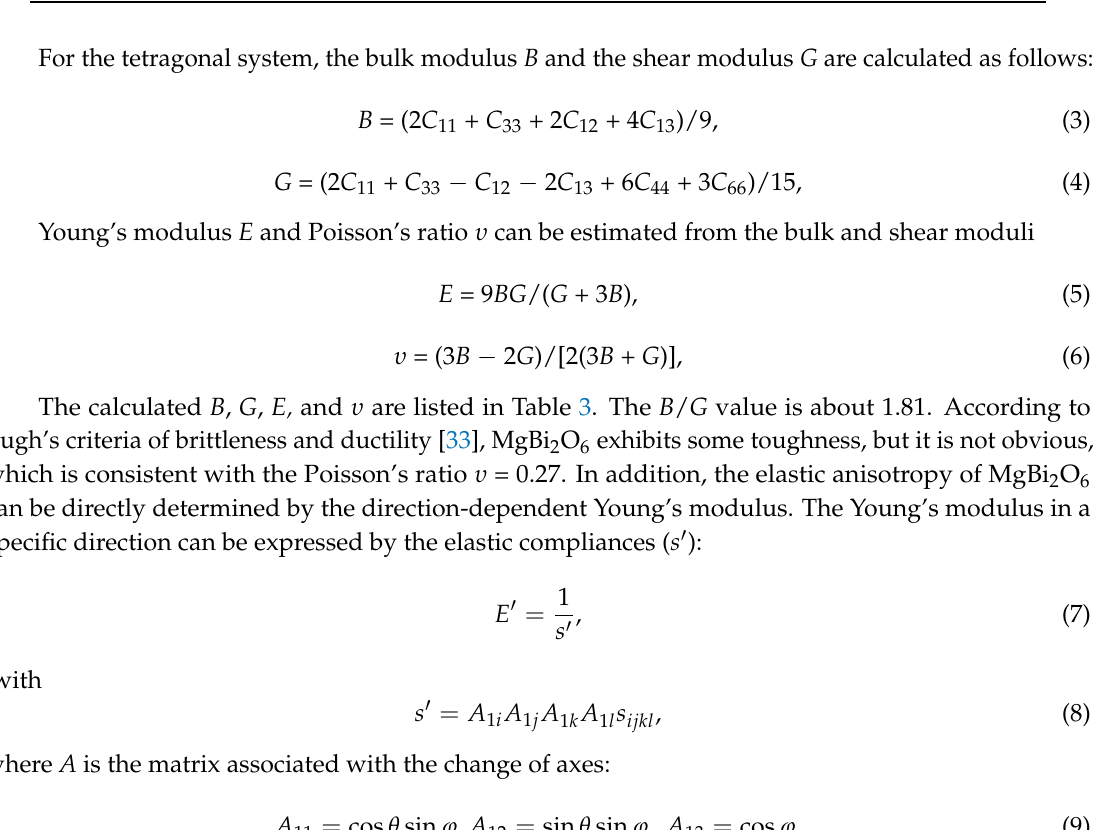
Table 3. Calculated elastic constants C ij , bulk modulus B , shear modulus G , Young’s modulus E , and Poisson’s ratio υ of MgBi 2 O 6 . Elastic Constants (GPa) Mechanical Moduli (GPa) υ C 11 C 12 C 13 C 33